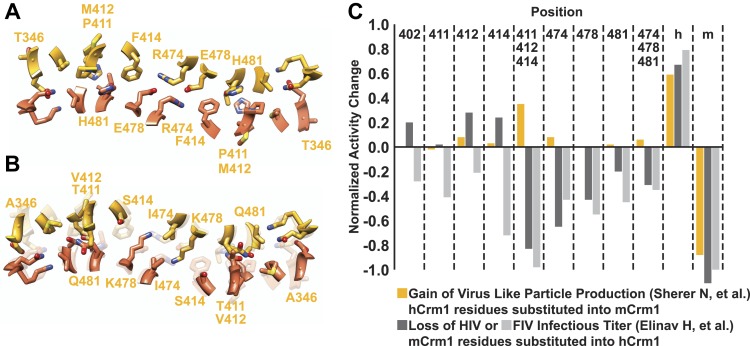
A comparison of species-specific residues at the interface of the Crm1 dimer.Species-specific residues form many interactions in the human Crm1 dimer interface (A) but few at the analogous murine positions (B). Aligning the Cα atoms from murine and human Crm1 at the dimer interface (B) shows steric clashes between side chains near Thr411 in murine Crm1 interface and between the side chains of His352 and Thr487 that would prevent murine Crm1 dimerization. (C) Swapping residues between human and murine Crm1 in the dimer interface alters virus production. A summary of data from references (Sherer et al., 2011) and (Elinav et al., 2012) testing the effect of murine or human residues on virus-like particle production or infectivity of HIV or FIV vectors shows the biological relevance of the Crm1 interface. Sherer et al. substituted human residues into murine Crm1 to determine which residues enhanced virus-like particle production (Sherer et al., 2011). Elinav et al. substituted mouse residues into human Crm1 and scored for loss of function (Elinav et al., 2012). In both studies, the gain in activity denoted by ‘h’ is a substitution of all human interface residues into murine Crm1 and vice versa for the loss of activity denoted by ‘m’. Data were normalized according to the following equations: Gain of Function = (mutant activity−murine Crm1 activity)/(human Crm1 activity−murine Crm1 activity) and Loss of Function = Gain of function−1.